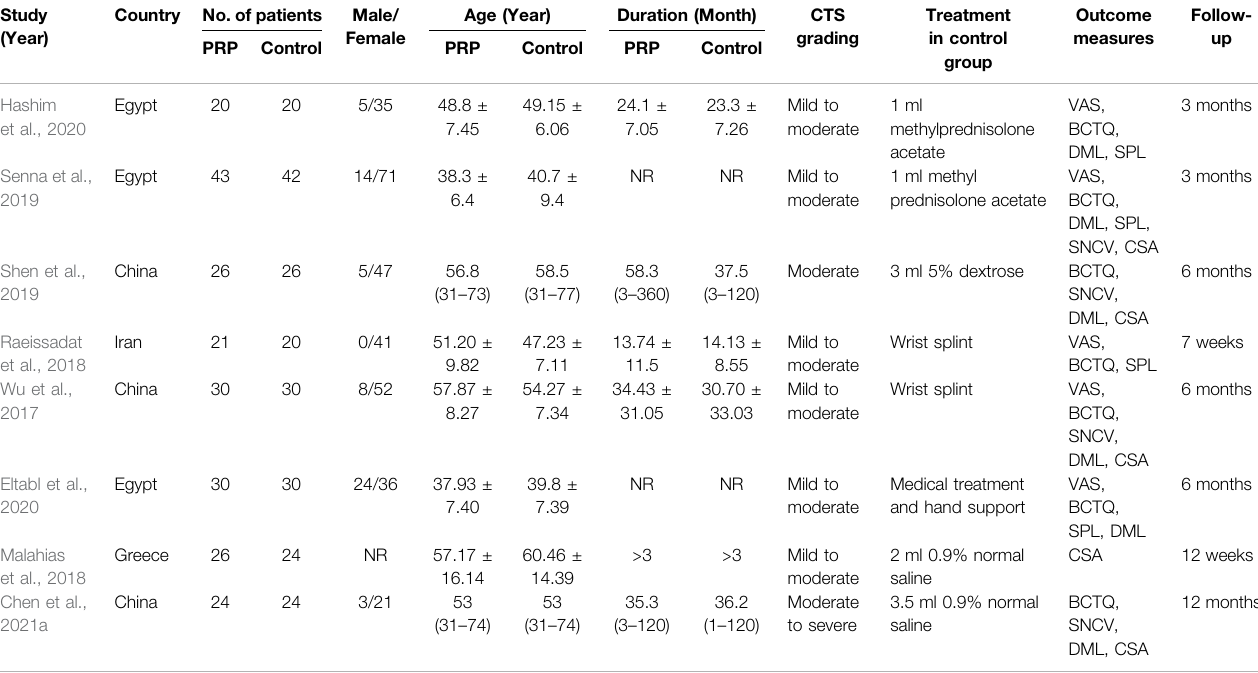
TABLE 1 | The main characteristics of the included